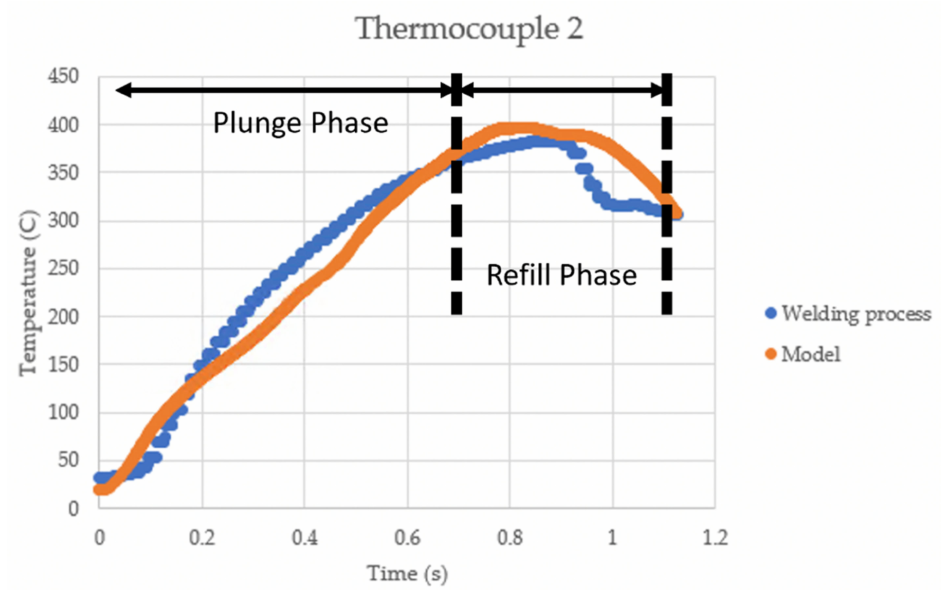
Figure 9. Thermal comparison for Thermocouple